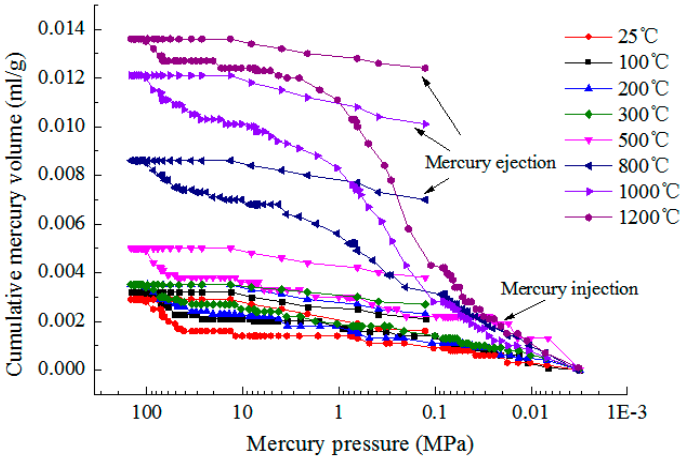
Figure 7. The mercury injection and ejection curves in granite samples heat-treated at different temperatures.